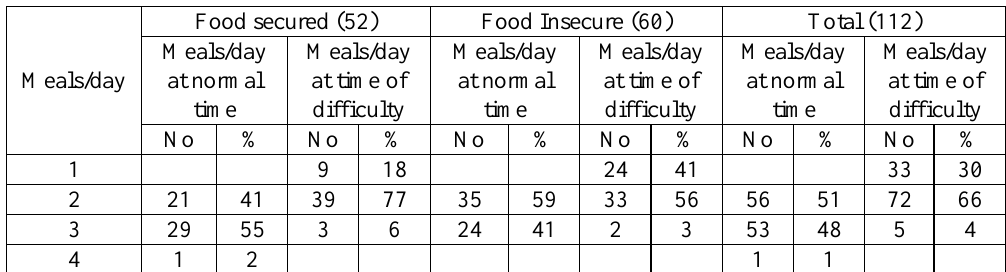
Table 9. Number of meals per day for adults between the age of 18 and 64 at normal time and time of difficulties